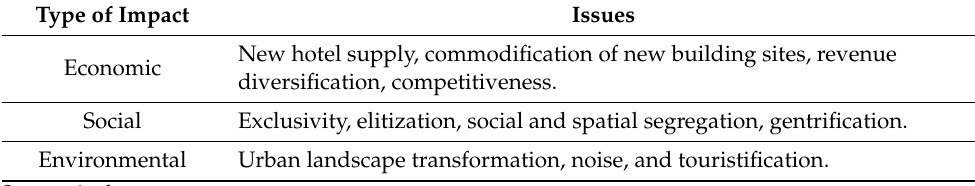
Table 3. Issues that are attributed to